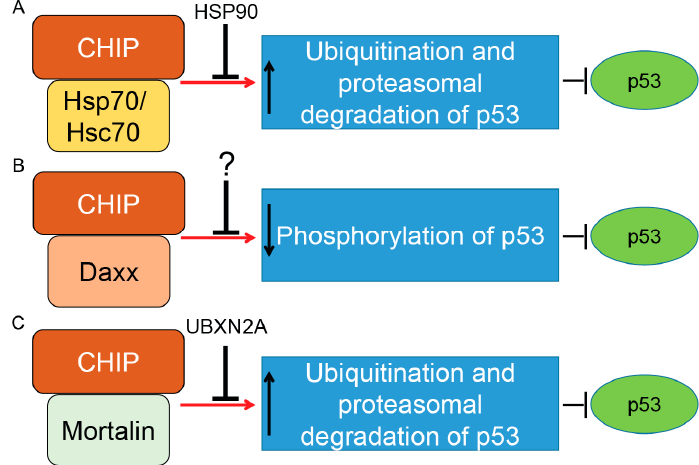
Figure 3. Control of p53 tumor suppressor protein by co-chaperone carboxyl terminus Hsp70/90 interacting protein (CHIP) E3 ubiquitin ligase. CHIP is a U-box-dependent E3 ubiquitin ligase. Association with chaperone proteins such as Hsp70/Hsc70 ( A ) or mitochondrial heat shock protein Mortalin-2 ( C ) allows CHIP to efficiently ubiquitinate p53 for proteasomal degradation. The present data indicate that Hsp90’s chaperone activity can inhibit CHIP/Hsp70–Hsc70–dependent degradation of p53 (wild-type and mutant forms). Thus, there is precise balance between the p53 degradation and the p53 stabilization maintained by CHIP–Hsp70–Hsc70 and Hsp90 under physiological and stress conditions. A similar inhibitory function was reported for UBXN2A protein, a ubiquitin-like (UBX) domain-containing protein, which binds and inhibits CHIP–mortalin degradation of p53 in cancer cells. CHIP also binds to the death-associated protein Daxx in a stress-dependent manner. The CHIP–Daxx interaction blocks phosphorylation of serine 46 in p53, which is necessary for activation of p53’s downstream apoptosis pathways ( B ). Blocking phosphorylation of p53 allows the CHIP–Daxx complex to interfere with the proteotoxic stress response of cells and maintain cell survival. Induction and inhibition of post-translational modification is shown by red arrows and black T-bars, respectively. Question mark indicates further research will be necessary to clarify the interactive and inhibitory effects of CHIP–Daxx complex.